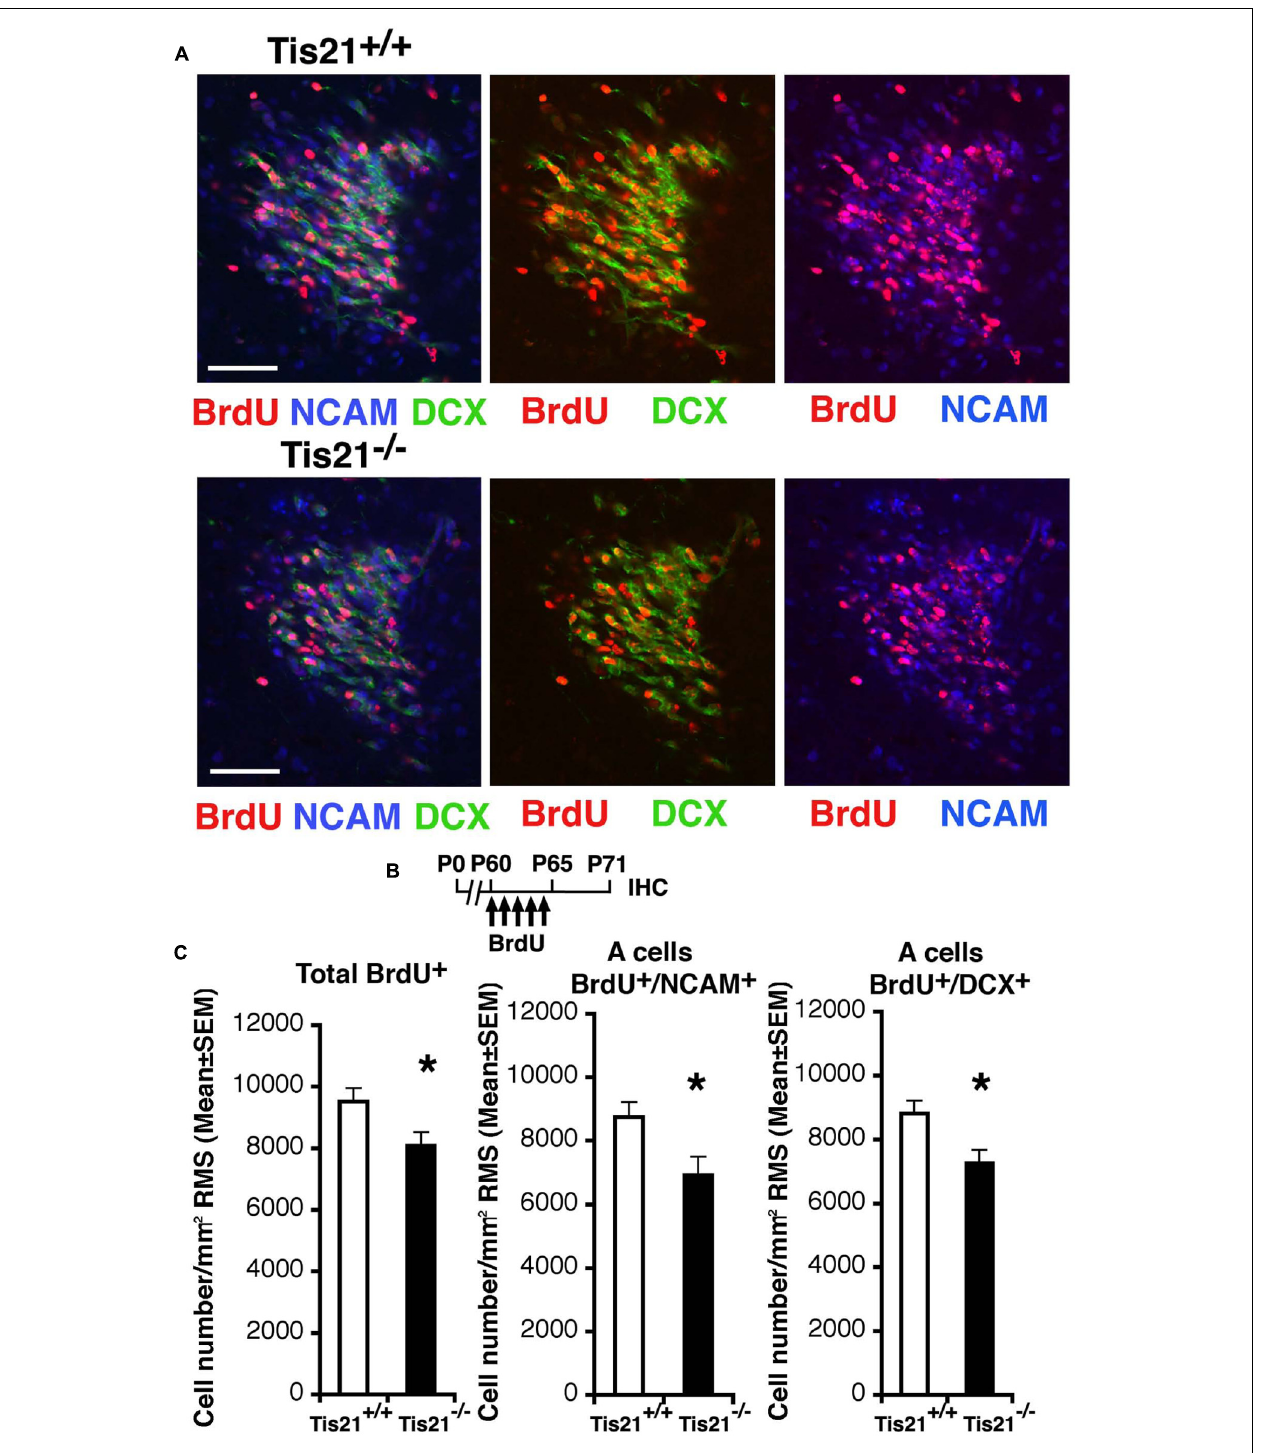
P60 and analysis performed 11 days after (P71). (C) Quantification throughout the whole RMS in P71 mice of the number per RMS area of the total (BrdU + ) cells and of the tangentially migrating A neuroblasts (BrdU + /NCAM + or BrdU + /DCX + ); the migrating neuroblasts decrease in number in Tis21 − / − mice relative to wild-type. Cell numbers are mean ± SEM of the analysis of three animals per group. * p < 0.05 vs. Tis21 + / + RMS; Student’s t